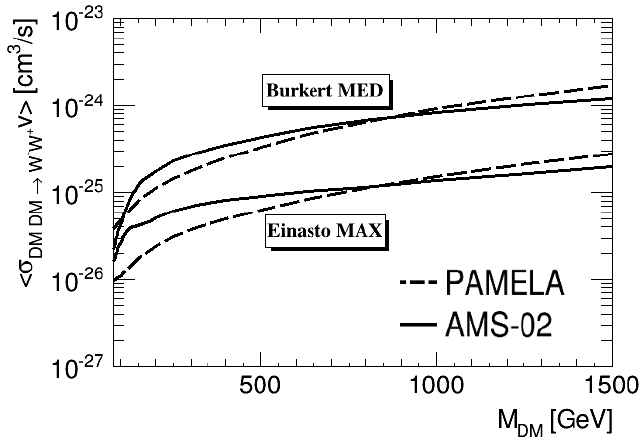
Figure 2 . Compared DM annihilation cross section upper limit from PAMELA (dashed) and AMS-02 (solid) antiproton data for the W boson channel with Burkert- Med and Einasto- Max